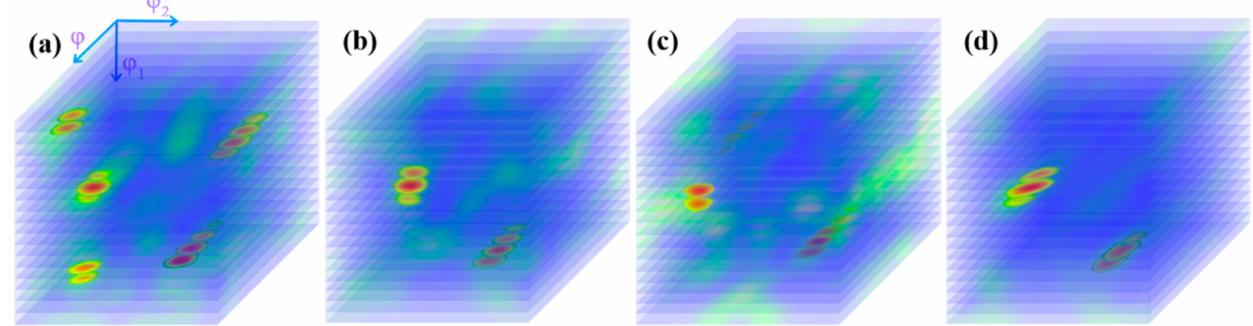
Figure 8. Orientation distribution function (ODF) of CEed sample at the processing temperature of 150 ◦ C: ( a ) 250 µ m from edge, ( b ) 1 mm from edge, ( c ) 2 mm from edge, and ( d ) 4 mm from edge.